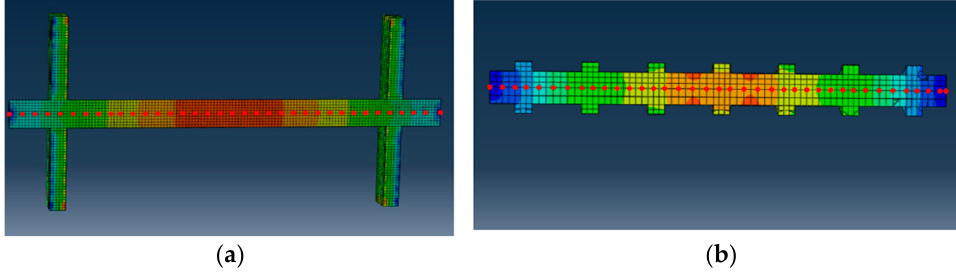
Figure 7. Axial point of sensing element, ( a ) points of the I-shaped sensor, ( b ) points of the corrugated-shape sensor.